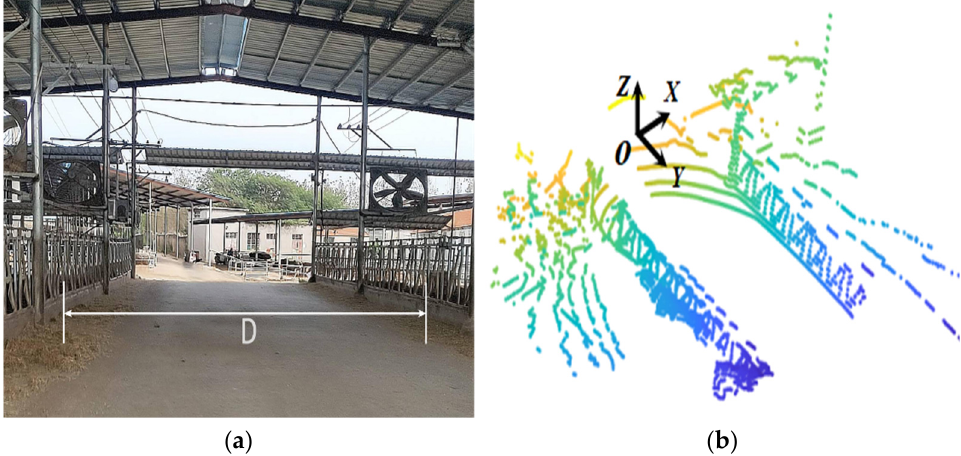
Figure 3. Cattle farm 3D point cloud acquisition: ( a ) Experimental cattle farm, ( b ) 3D point cloud of the original cattle farm.